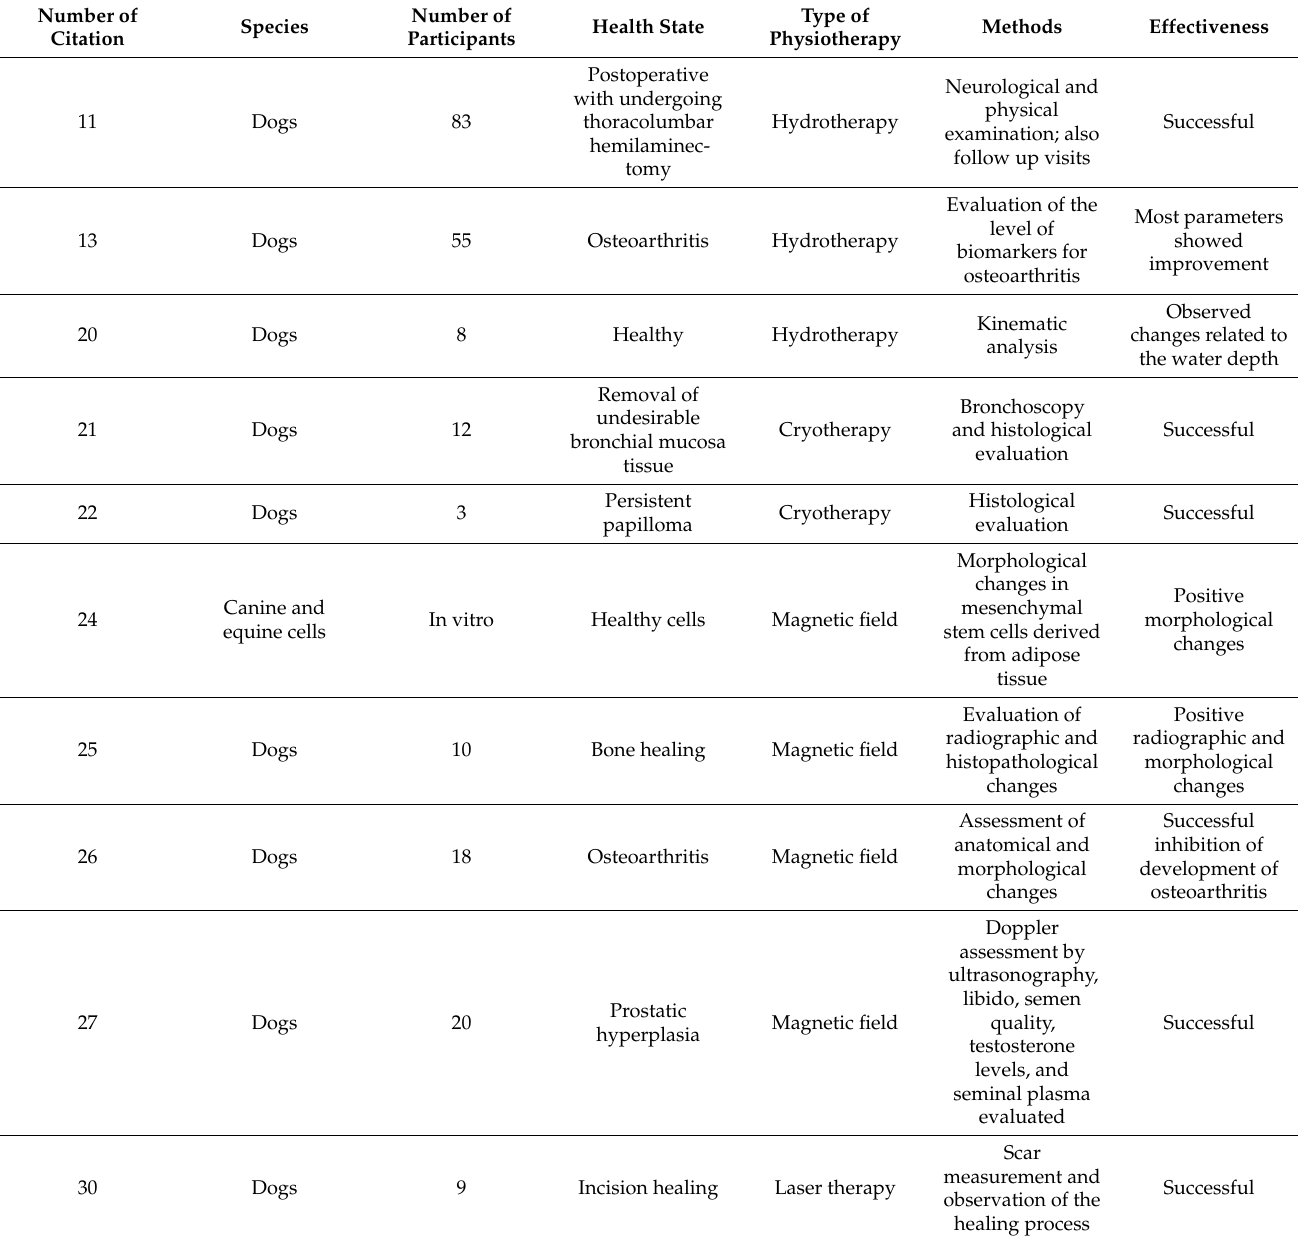
Table 1. Juxtaposition of data from original research